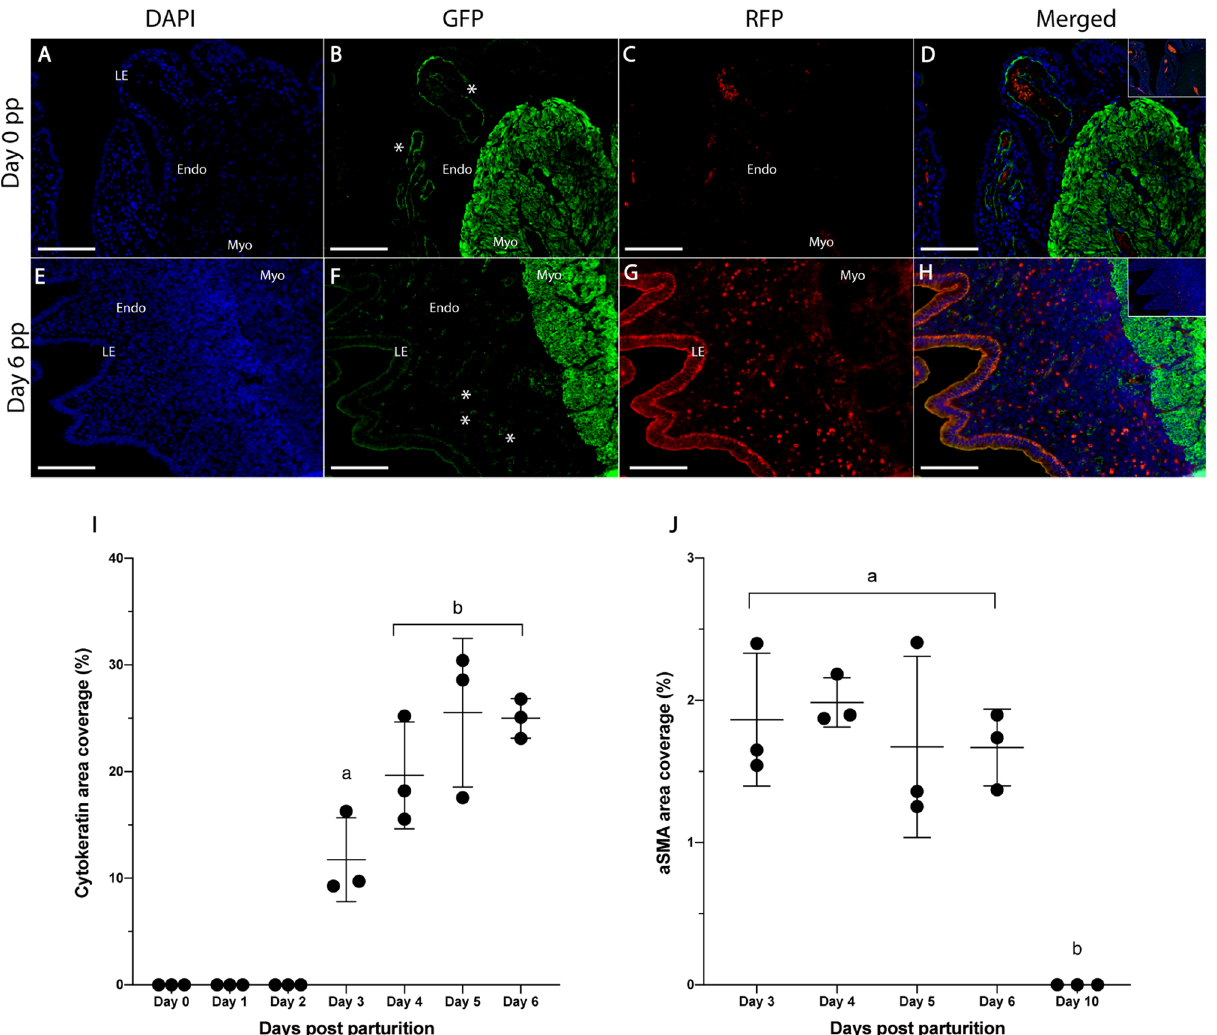
Figure 4. Comparative changes in cytokeratin and aSMA expression in the spiny mouse postpartum endometrium. Blue = DAPI, Green = aSMA, Red = Cytokeratin. A cluster of aSMA positive arteries in the endometrium (* in B ) and strong aSMA positive staining in the myometrium of day 0 pp sections. Arteries in the superficial endometrium of day 6 pp sections (* in F ) are aSMA positive. Spiral arteries were first seen on day 3 pp ( J ) and the area coverage of aSMA positive tissue was not significantly different across days 3–6 pp but was significantly higher than day 10 pp ( J ). The day 0–2 pp luminal epithelium is negative for cytokeratin ( C ), however cytokeratin is detected in the luminal epithelium by day 3 pp ( I ). Cytokeratin reached maximal expression by day 4 pp ( I ). Day 0–2 pp endometria were omitted from aSMA analysis as there was no clear stratum functionalis. As the uterine lumen was closed by day 10 pp, this timepoint was removed from cytokeratin analysis. Inset squares ( D , H ) are negative controls of the same tissue. Data depict mean ± SD and data with different letters differ significantly (p < 0.05; ANOVA). Scale bars for ( A – H ) are 100um. Endometrium (Endo), myometrium (Myo), luminal epithelium pituitary hormones (including prolactin) have not been reported in this species and remain a future direction for spiny mouse research. During the first 3 days postpartum, the endometrium is thin, consisting essentially of the stratum basalis. In menstruating species, decidualisation of the endometrium occurs solely in the stratum functionalis, which is later shed during menses or parturition 4,7 . Moreover, endometrial thickness during days 0–2 pp is similar to the endometrial thickness during the early follicular phase in this species and by day 3 pp, repair and growth of the endometrium has begun. The endometrium at this stage is structurally similar to the luteal phase in A. cahirinus 7 , suggesting a similar timeframe for postpartum endometrial repair and growth as during the menstrual cycle. Thus, our data show that the postpartum reproductive tract has similar structural and physiological character- istics to follicular and luteal phase reproductive tracts of spiny mice during the menstrual cycle. Rodents undergo eccentric embryo implantation by gestational day 5 with the blastocyst forming an implan- tation ‘chamber’ in the superficial layer of the endometrium without fully invading the underlying stroma 15,36 .